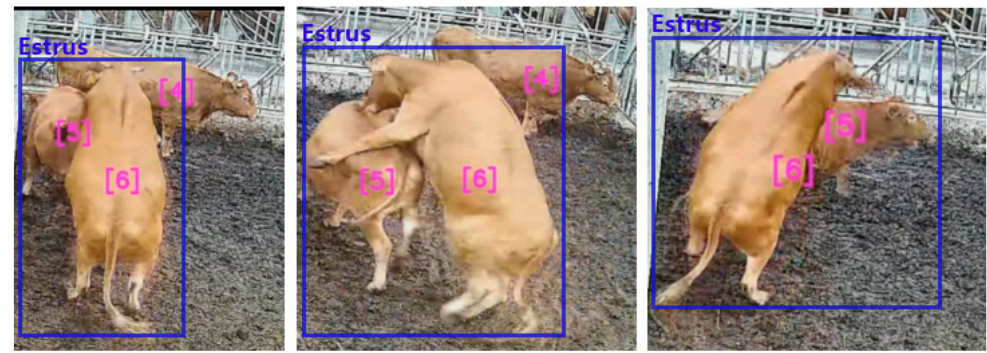
Figure 14. ARM’s detection of mounting